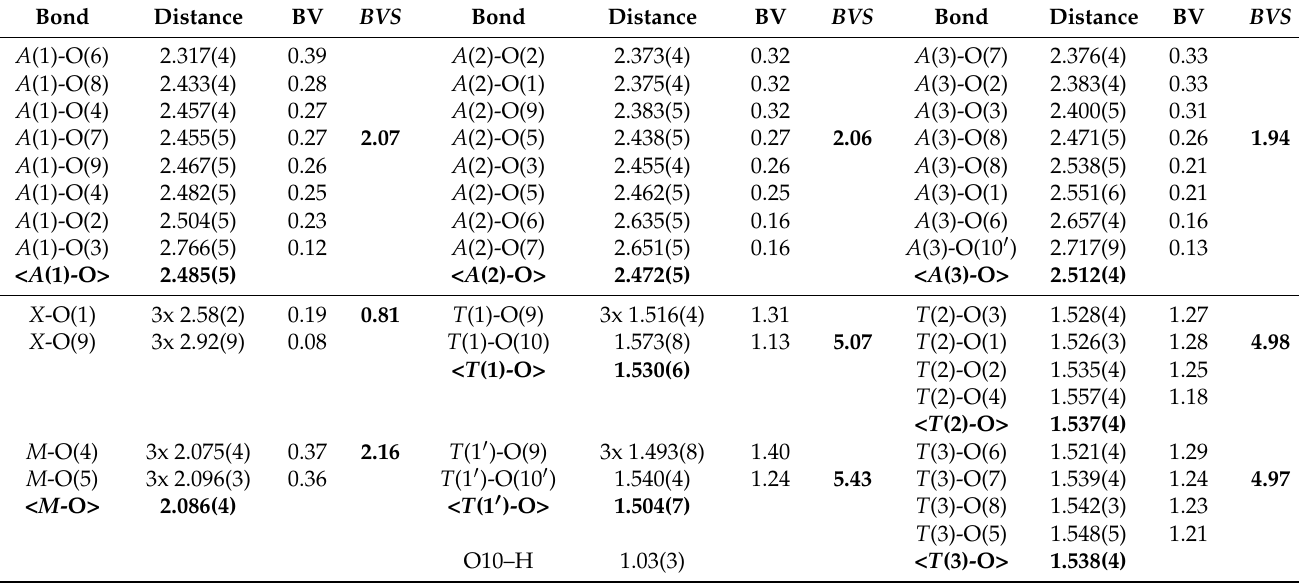
Table 6. Bond distances (Å) and bond valence/sum (BV/BVS, in valence units = v.u.) within the studied whitlockite (from NDP data). BV/BVS values for the A (2) and M sites calculated according to the single cationic occupancies (Table 3).